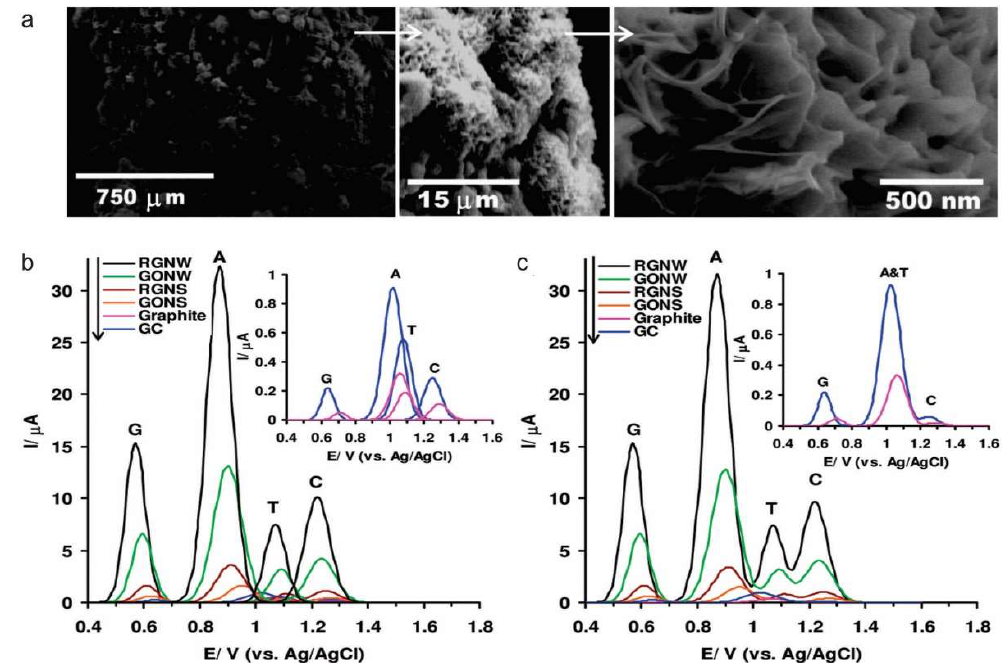
Figure 3. ( a ) Scanning electron microscopy images of the graphene oxide nanowalls deposited on a graphite rod by using electrophoretic deposition ( b , c ) Differential pulse voltammetric profiles of the reduced graphene nanowalls (RGNW), graphene oxide nanowalls (GONW), reduced graphene nanosheet (RGNS), and graphene oxide nanosheet (GONS) electrodes as compared to the graphite and glassy carbon (GC) electrodes for detection of ( b ) the four free bases of DNA (G, A, T, and C) separately, and ( c ) equimolar mixture of G, A, T, and C. Reproduced with permission from [71], Copyright American Chemical Society, 2012.